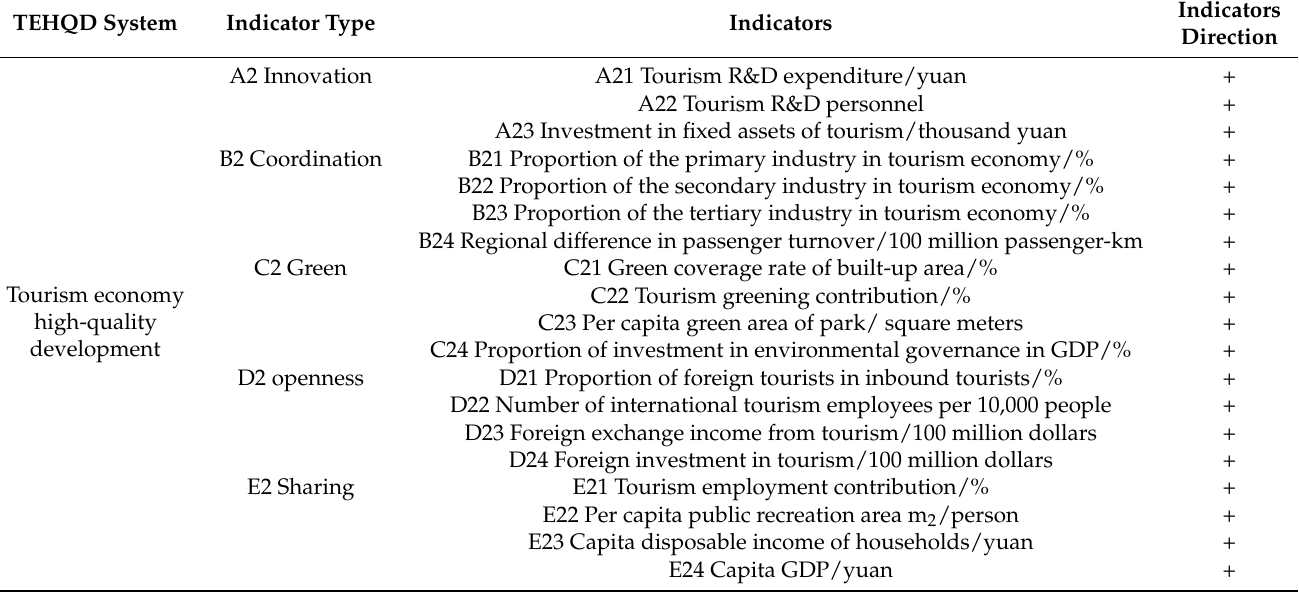
Table 2. Evaluation index system of the tourism economy’s high-quality development (TEHQD). TEHQD System Indicator Type Indicators